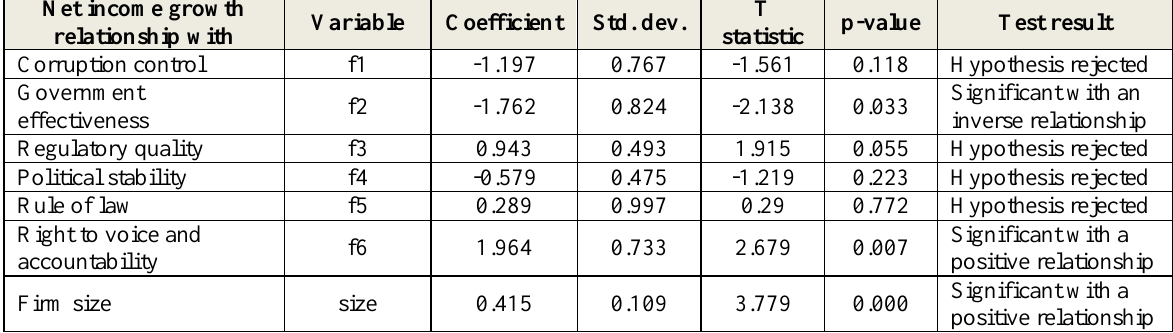
Table 3. The relationship between net income growth and governance indicators using the GLS method Net income